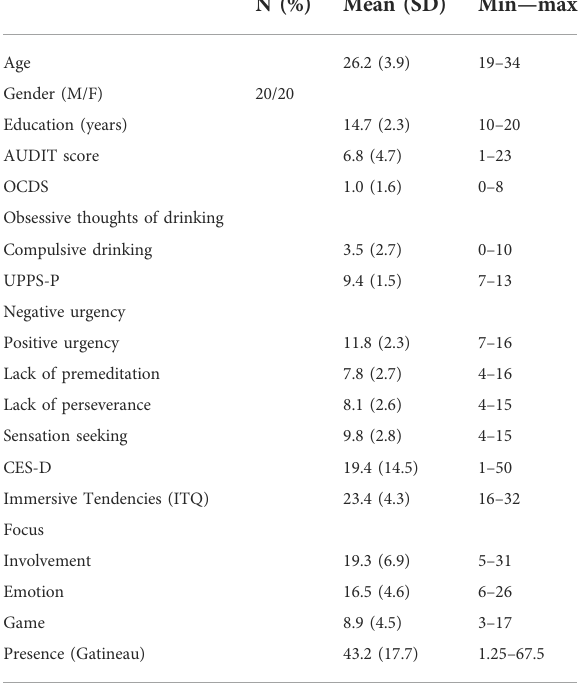
TABLE 1 Demographic data, psychological characteristics and sense of